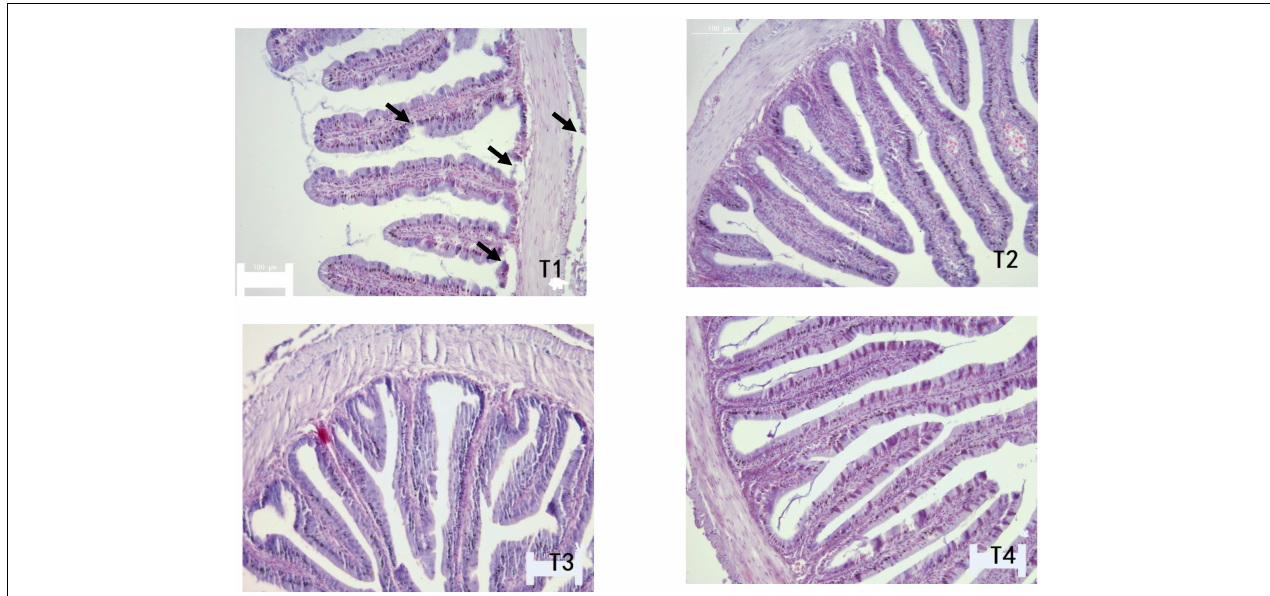
FIGURE 2 | Photomicrographs of transverse HE-stained sections of the foregut of E. coioides fed tested diets for 56 days (100 × ). TABLE 7 | Alpha ( α )-diversity index of intestinal microbiota in grouper ( E. coioides ) at day 56. Control